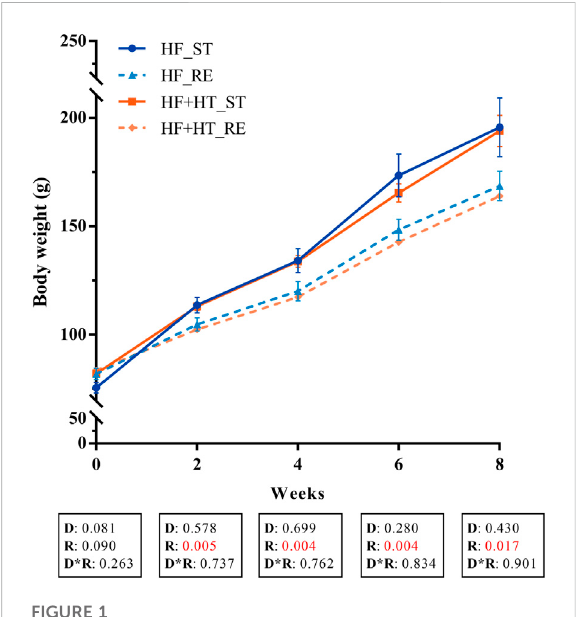
FIGURE 1 Mean body weight of gilthead sea bream juveniles fed with a high-fat diet in the absence (HF) or presence (HF + HT) of hydroxytyrosol(0.52 gHT/kgfeed),atastandard(ST)(3%biomass/ tank) or restricted ration (RE) (40% daily reduction), for 0, 2, 4, 6 and 8 weeks. Values are presented as Mean ± SEM ( n = 3 tanks). Statistical differences are indicated in 3 components: diet (D), ration (R) and interaction (D*R), using two-way ANOVA ( p < 0.05, showed in